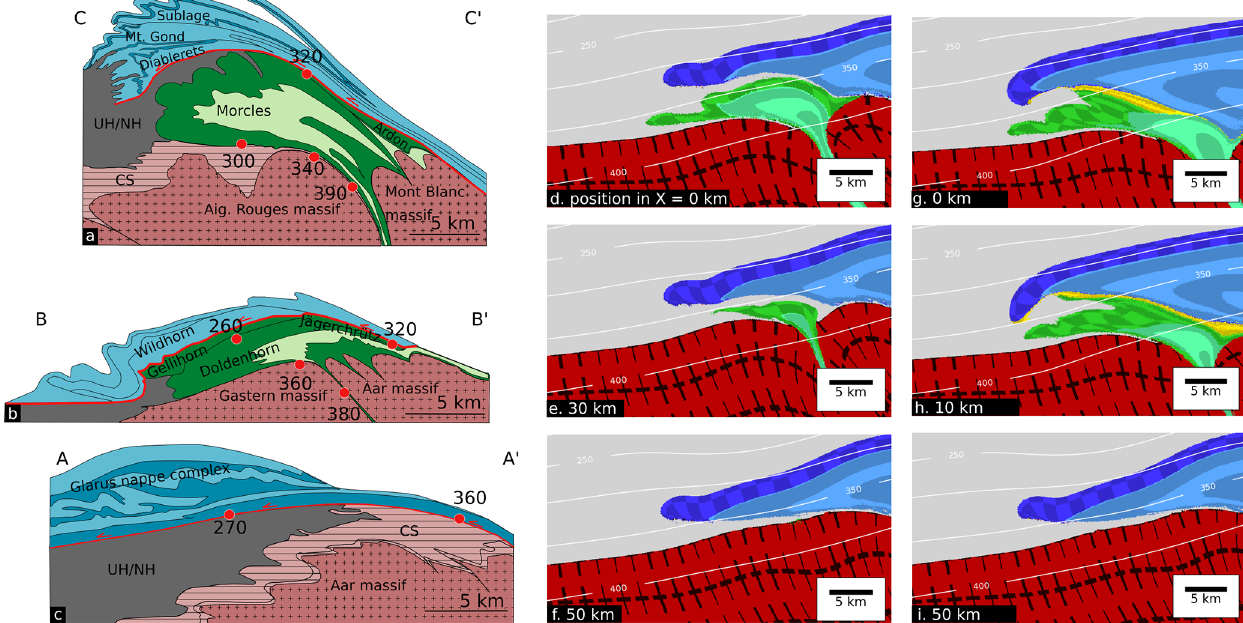
Figure 13. Comparison between the geological cross sections of the Morcles nappe, Doldenhorn nappe and Glarus nappe complex with sections taken from our numerical simulations. Columnwise (left to right): (a–c) geological-cross sections, (d–f) sections from model A.G-1, and (g–i) sections from model D.G-1. Black numbers in sections of (a–c) are estimated peak temperatures in degrees Celsius taken from Ebert et al. (2008). UH/NH represents Ultrahelvetics/North Helvetics. CS represents cover